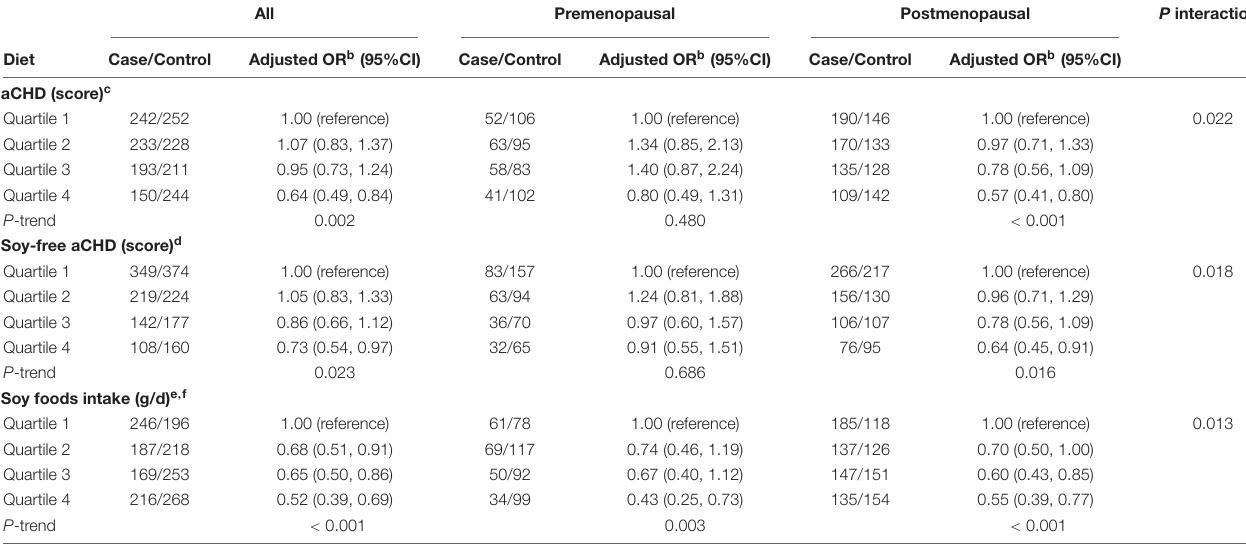
TABLE 2 | Associations (OR and 95%CIs) between the alternate Chinese Diet Score (aCHD), the soy-free alternate Chinese Diet Score (soy-free aCHD), and soy foods daily intake and breast cancer, stratified by menopausal status. a